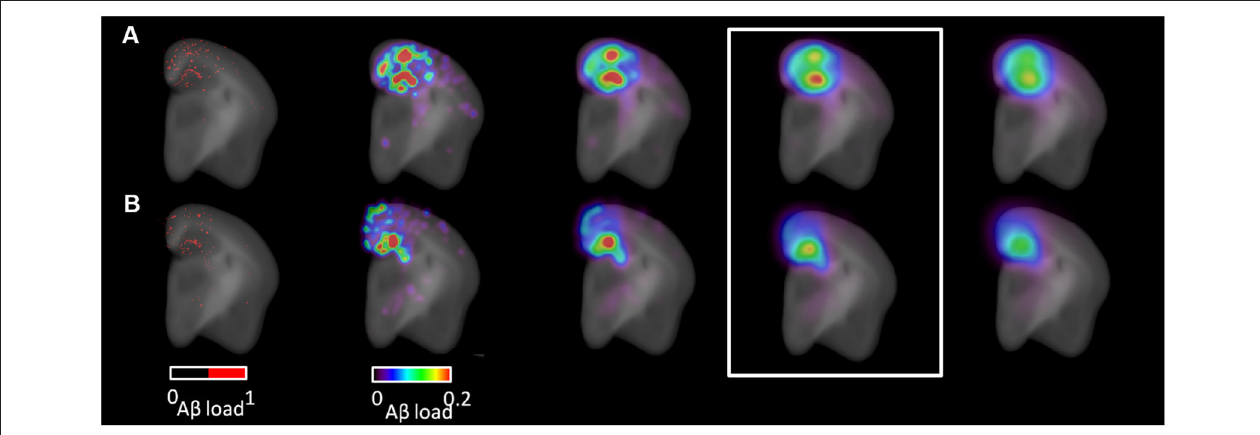
FIGURE 5 | Parametric map generation. Coronal view images from (A) an APP Swe , Ind -ADAM30 mouse and from (B) an APP Swe , Ind -Cre-ADAM30 mouse. Left: segmented A β plaques (red) superimposed with the anatomical template. Right: parametric maps derived from the segmented image and superimposed with the anatomical template. Parametric maps are shown with increasing values of Gaussian kernel smoothing standard deviation (from left to right: 90, 180, 270, 360 µ m). The Gaussian kernel standard deviation of 270 µ m was selected for voxel-based testing (white